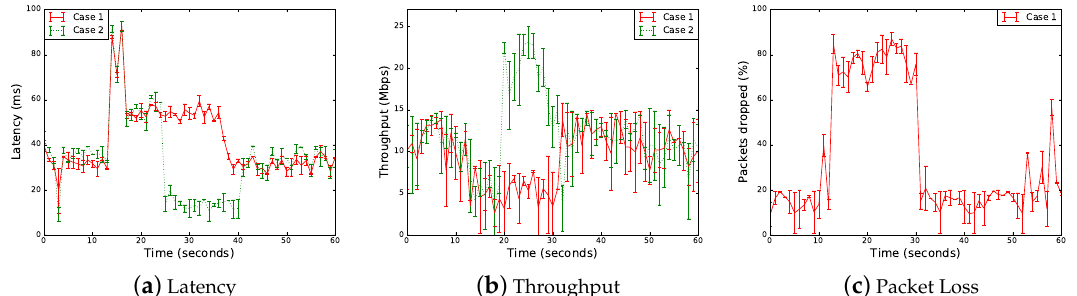
Figure 6. Experiment metrics measured when the vehicle travels outside the reach of eNodeB A1 towards A2 through the coverage B1 and A2 for Case 1 of no slicing federation and Case 2 with